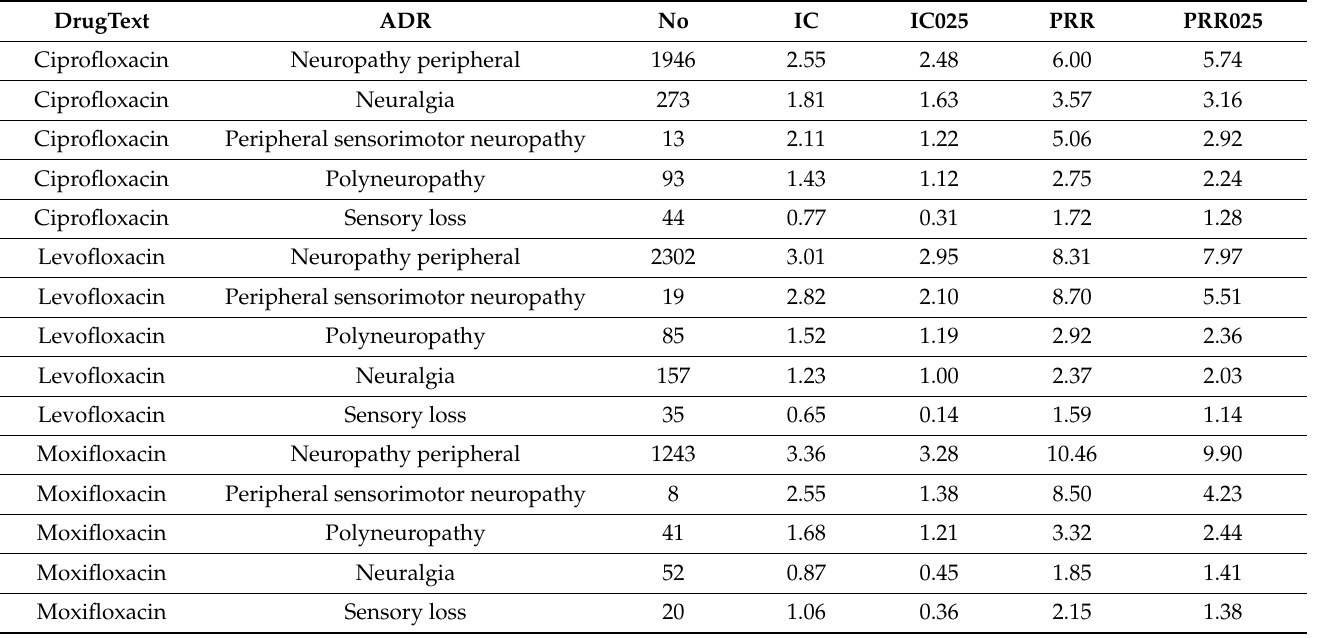
Table 1. Fluoroquinolone—Adverse drug reaction positive association